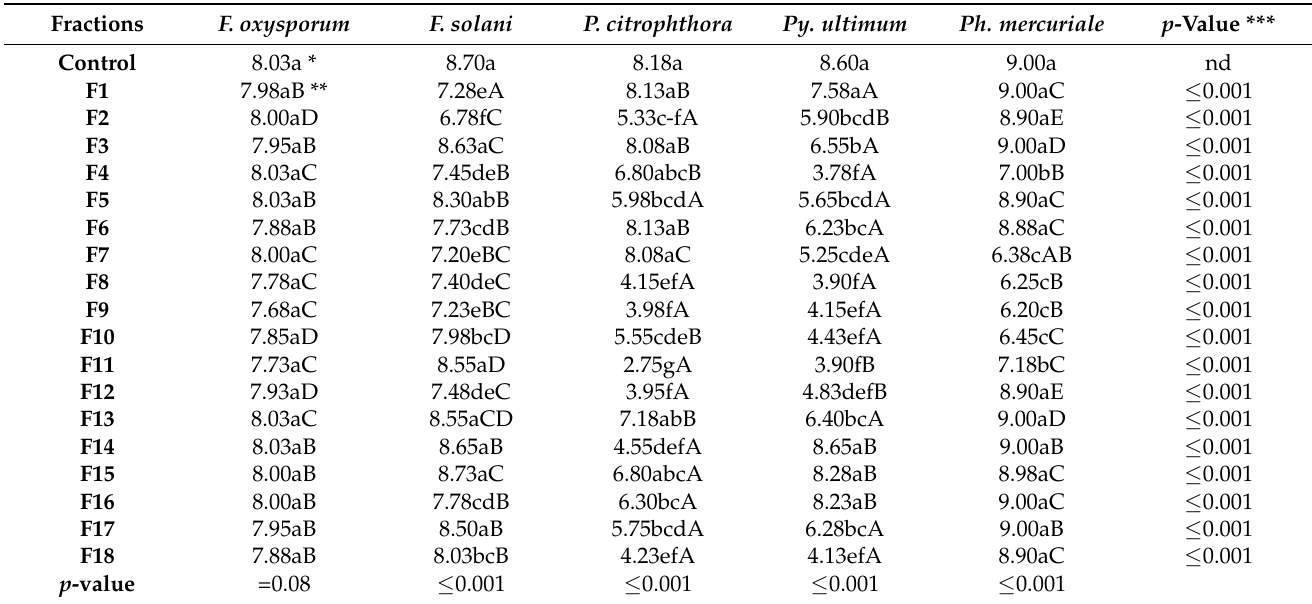
Table 5. Effect of Raphanus raphanistrum dichloromethane extract fractions on mycelial growth (cm) of Fusarium oxysporum , F. solani , P. citrophthora recorded after six days of incubation and that of Py.ultimum and Ph. mercuriale noted after two days of incubation at 25 ◦